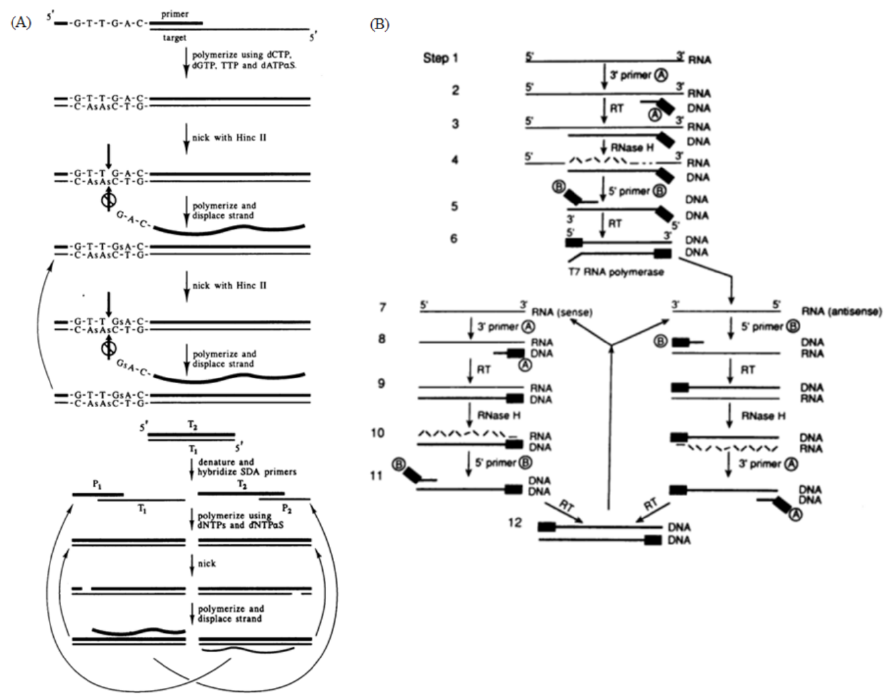
Figure 4. ( A ) Principle of SDA, generation of target amplification and exponential amplification. The two pairs of primers extend into double strands under the catalysis of the polymerase, and the endonuclease then cuts the newly synthesized strands between the primer and the template, allowing the new polymerase to bind and amplify the template while replacing the old strand. Reprinted with permission from Ref [50]. Copyright 1992, Walker et al. ( B ) Schematic of the NASBA mechanism. A reverse transcription primer containing the T7 promoter was used to reverse-transcribe the RNA target into a cDNA containing the T7 promoter, and then the cDNA was transcribed by the T7 RNA polymerase to obtain a large number of RNA amplification products; the synthesized RNA amplification products could re-enter the reverse transcription and transcription amplification cycle. Reprinted with permission from Ref. [51]. Copyright 1990, Guatelli et